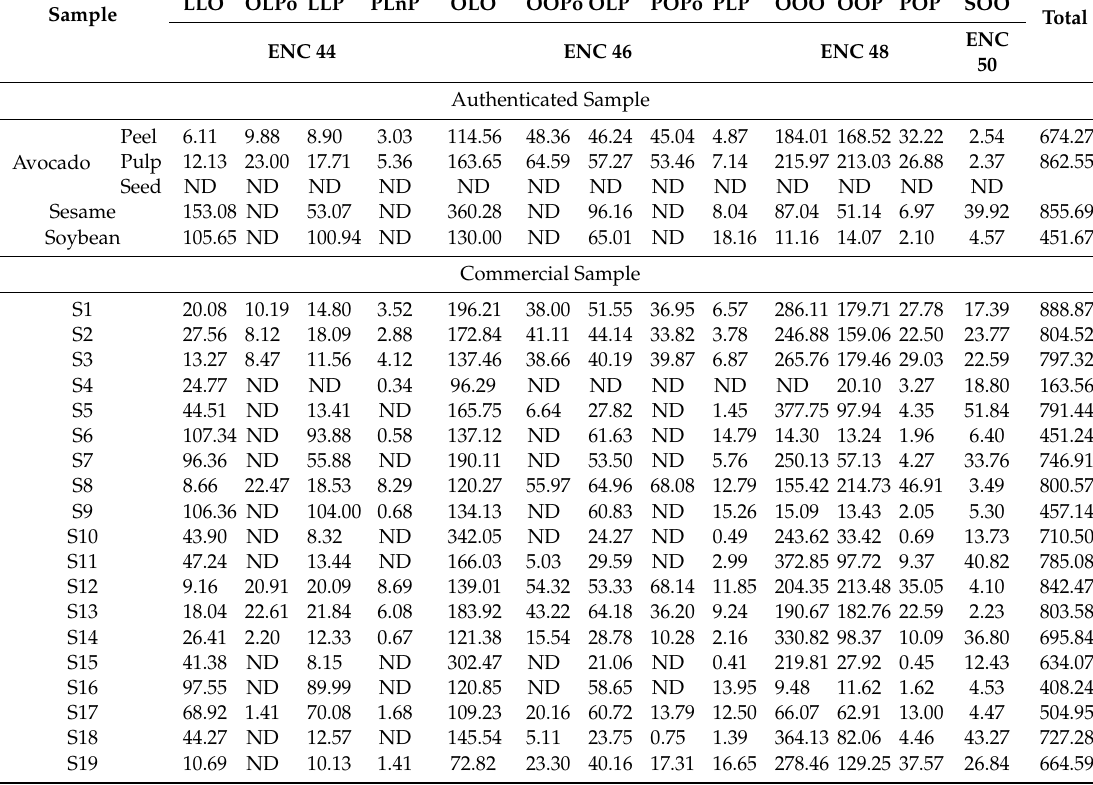
Table 3. Concentrations (mg / g) of TGs quantified in authenticated and commercial